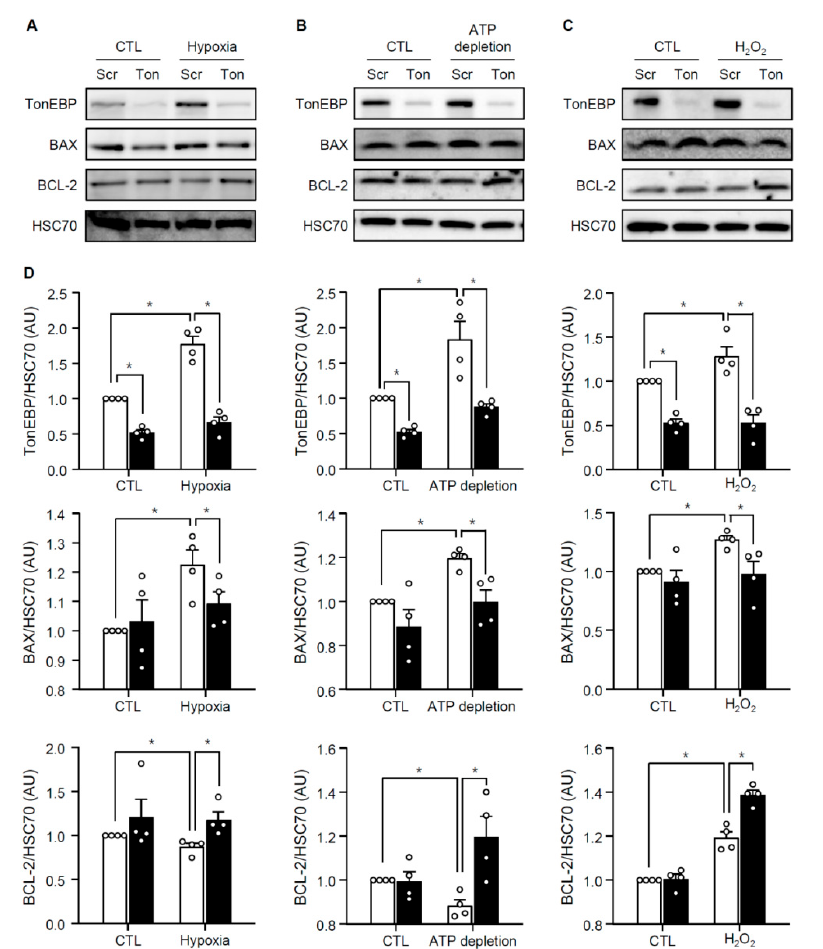
Figure 7. Effects of TonEBP knockdown on the expression of Bax and Bcl-2. HK-2 cells were transfected with TonEBP targeted siRNA (Ton, filled bars) or scrambled siRNA (Scr, open bars) followed by hypoxia ( A ), ATP depletion ( B ), or H 2 O 2 treatment ( C ). CTL, not treated. Cell lysates were immunoblotted for TonEBP, Bax, Bcl-2 and Hsc7, ( D ) TonEBP/Hsc70, Bax/Hsc70 and Bcl-2/Hsc70 ratio are shown. Mean ± SEM, * p < 0.05.